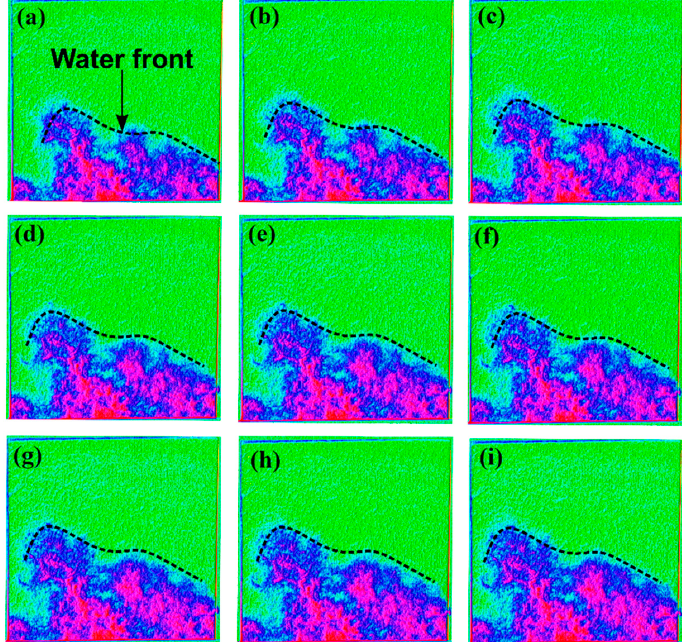
Figure 6 . False-colored transmission images of water imbibition in PA1 sample at ( a ) 40 s, ( b ) 2560 s, ( c ) 3840 s, ( d ) 5120 s, ( e ) 6400 s, ( f ) 7680 s, ( g ) 8960 s, ( h ) 10,240 s, and ( i ) 11,560 s. In green, the 5 × 5 cm 2 surface area of the limestone is displayed, whereas the blue/purple/red regions account for the liquid phase characterized by an ever-increasing amount of water. The quantitative evaluation of the water content is addressed from the analysis of the wetting profiles (see text for details).